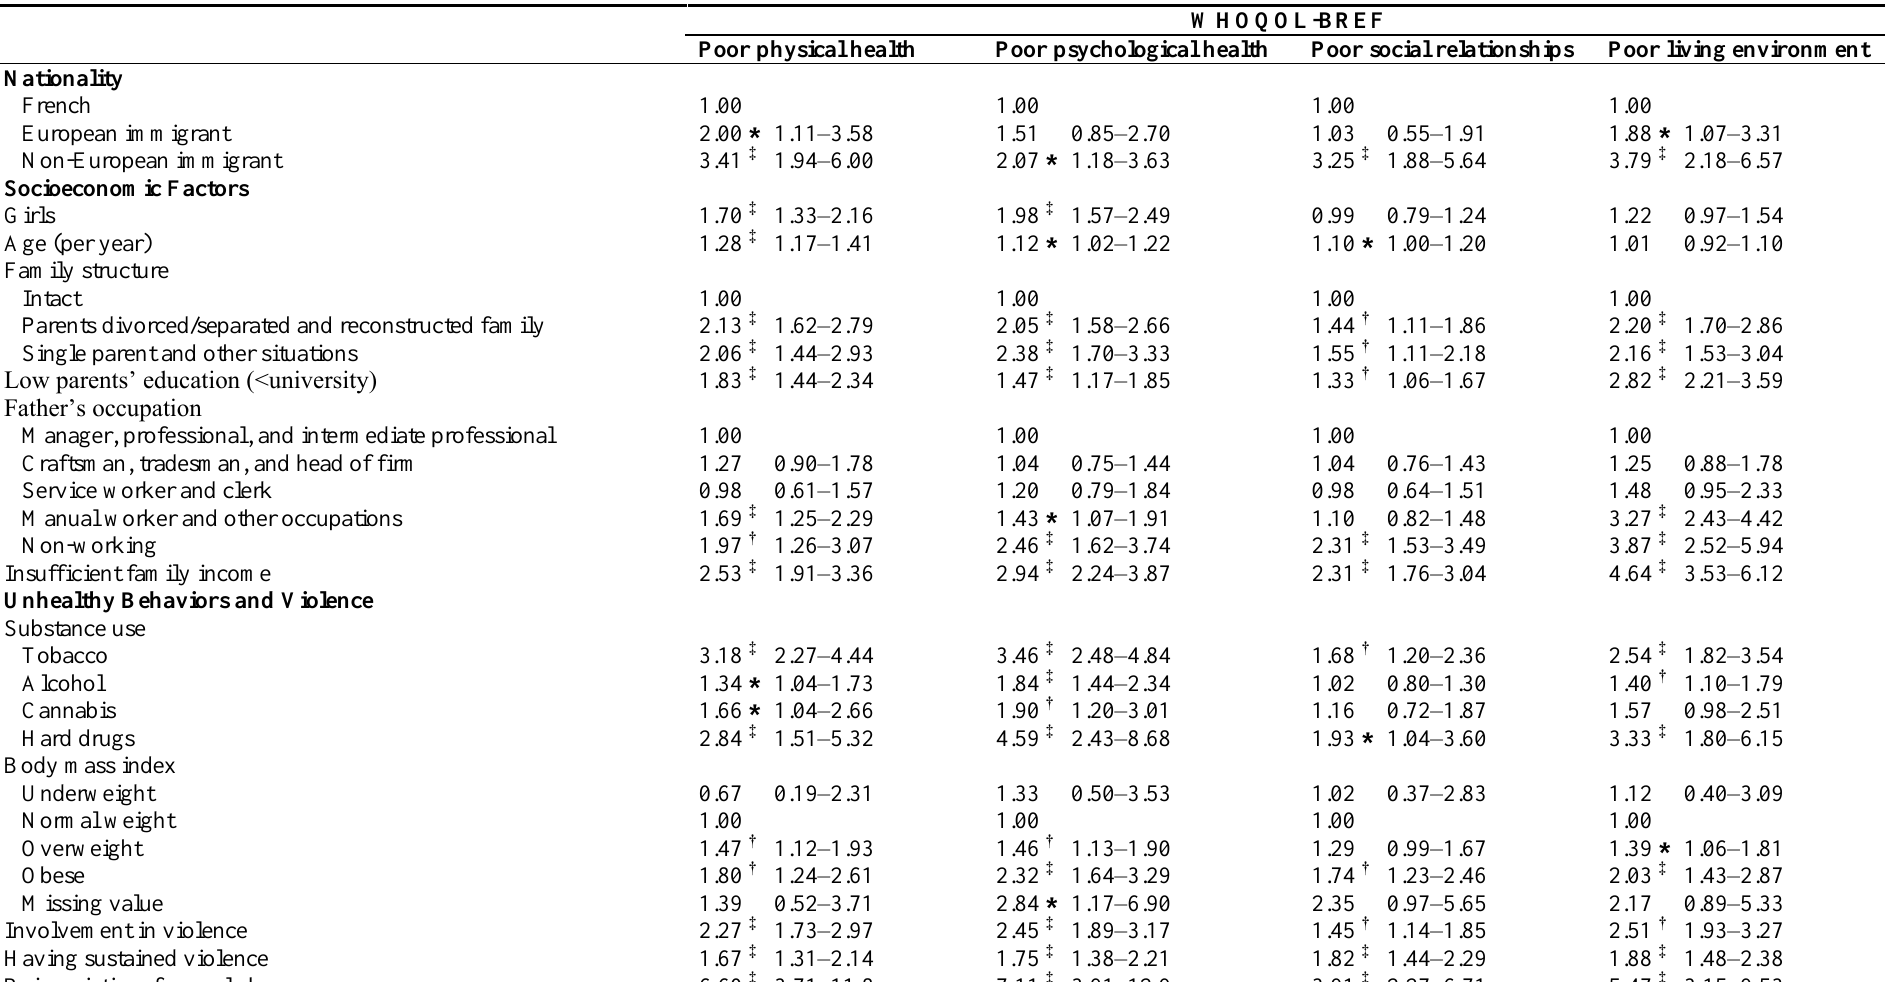
Table 3. Factors associated with physical health, psychological health, social relationships, and living environment: gender-age-adjusted odds ratio and 95% confidence